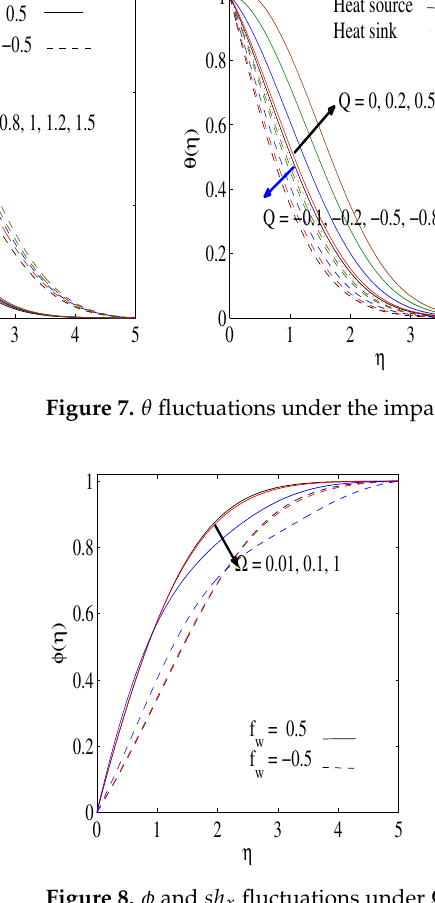
Figure 8. φ and sh x fluctuations under Ω factor impact.